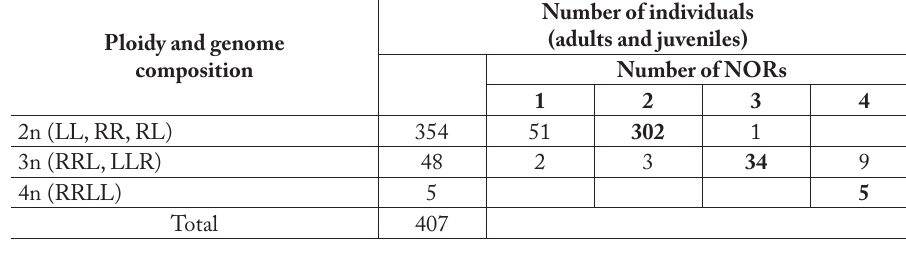
Table 3. Number of NORs in individuals of various ploidy level. The number of NORs that is in agree- ment with ploidy level is in bold.